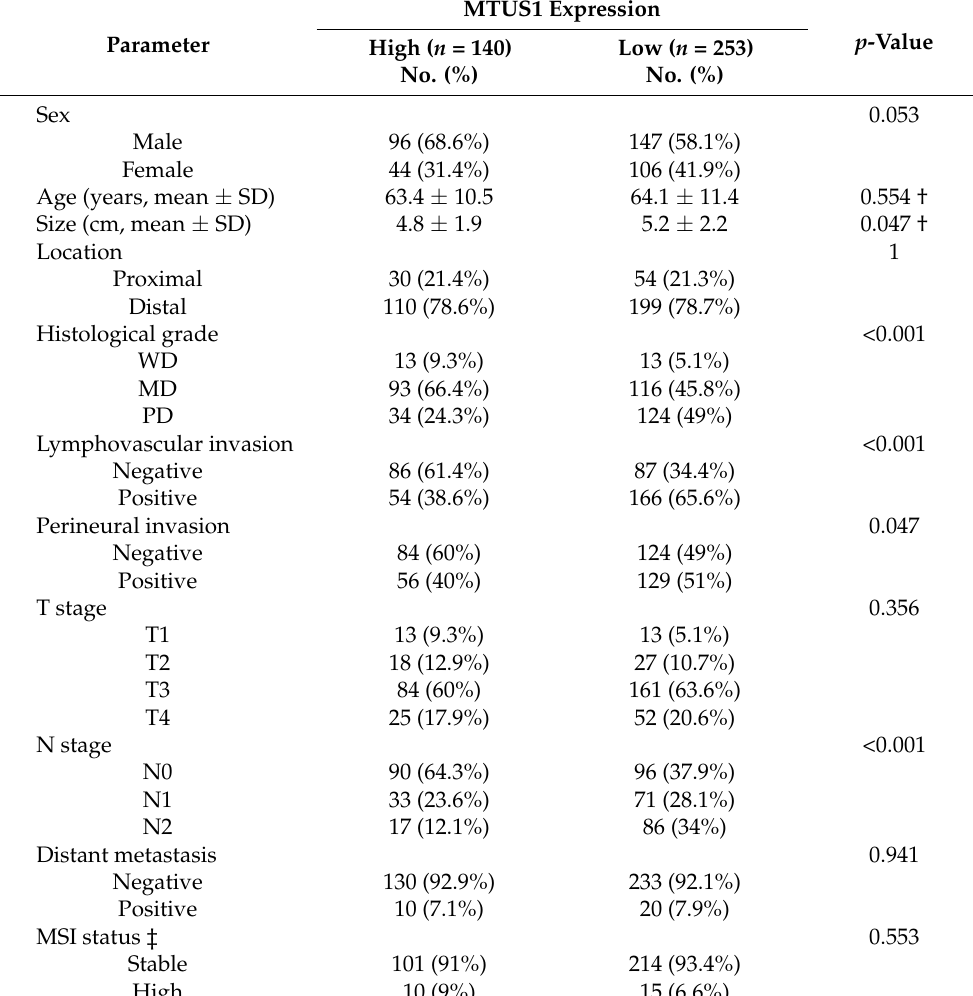
Table 2. Correlations between MTUS1 expression and clinicopathological parameters ( n =